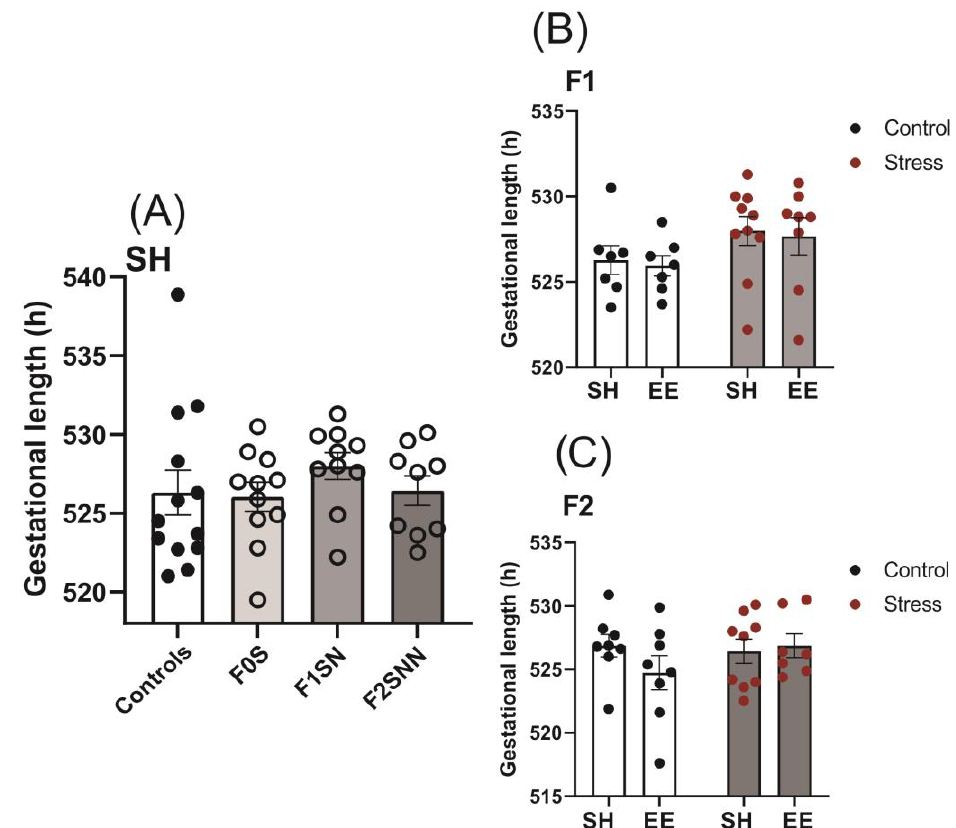
Figure 2. Gestational lengths were unchanged in animals subjected to PNMS. ( A ) Gestational lengths among treatment groups. Gestational lengths in control and stress groups exposed to either SH or EE housing conditions in the ( B ) F1 and ( C ) F2 generations. Data are compared to F0N, mean ± SEM. Ordinary one-way analysis of variance (ANOVA) ( A ) and two-way ANOVA ( B , C ) analyses were used. N = 9–13 ( A ) or 7–10 ( B , C ). SH = standard housing; EE = enriched housing; F = filial generation; S = stressed; N = nonstressed.